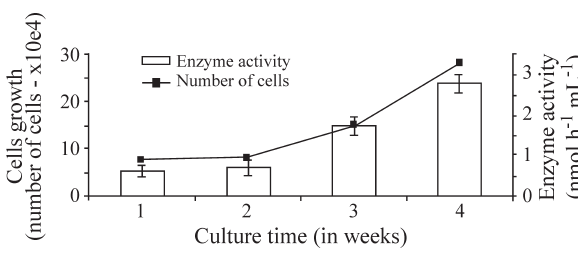
Figure 4 - Cell count for encapsulated baby hamster kidney (BHK) and β -galactosidase activity in the culture medium. The cells were encapsu- lated using an airflow of 15 L min -1 and a peristaltic pump rate of 100 mL h -1 to produce a microcapsule size of 0.4 mm ± 0.05